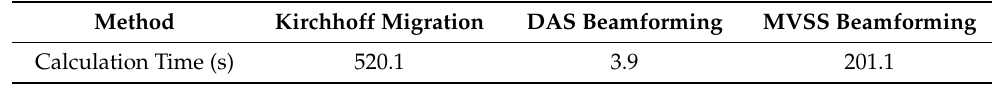
Table 4. Calculation time of each method.